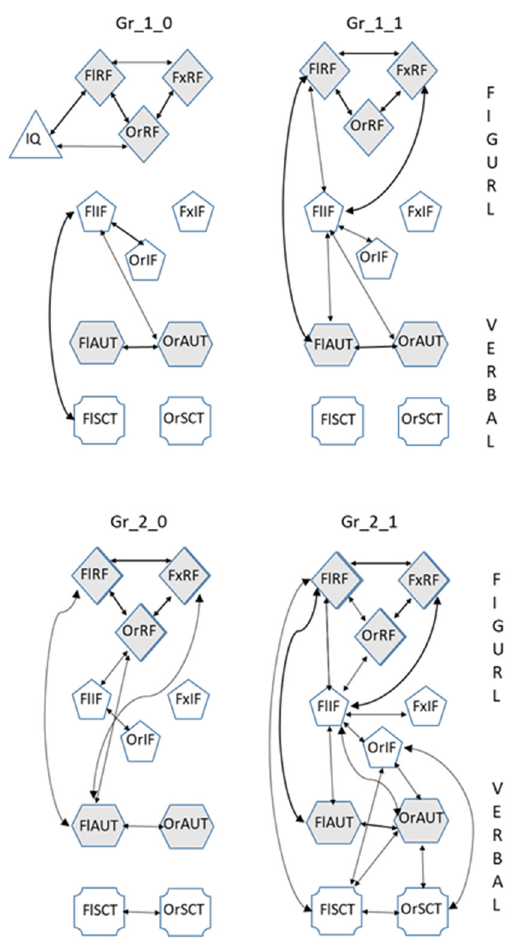
Figure 3. The relationships between the indicators of creativity due to age and academic scores. Gr_1_0 or Gr_1_1 and Gr_2_0 or Gr_2_1 are the sub-groups of schoolchildren and students, respec- tively, with lower or higher average academic score. Thicker lines with arrows show correlations significant at 0.01. Thinner lines show correlations significant at